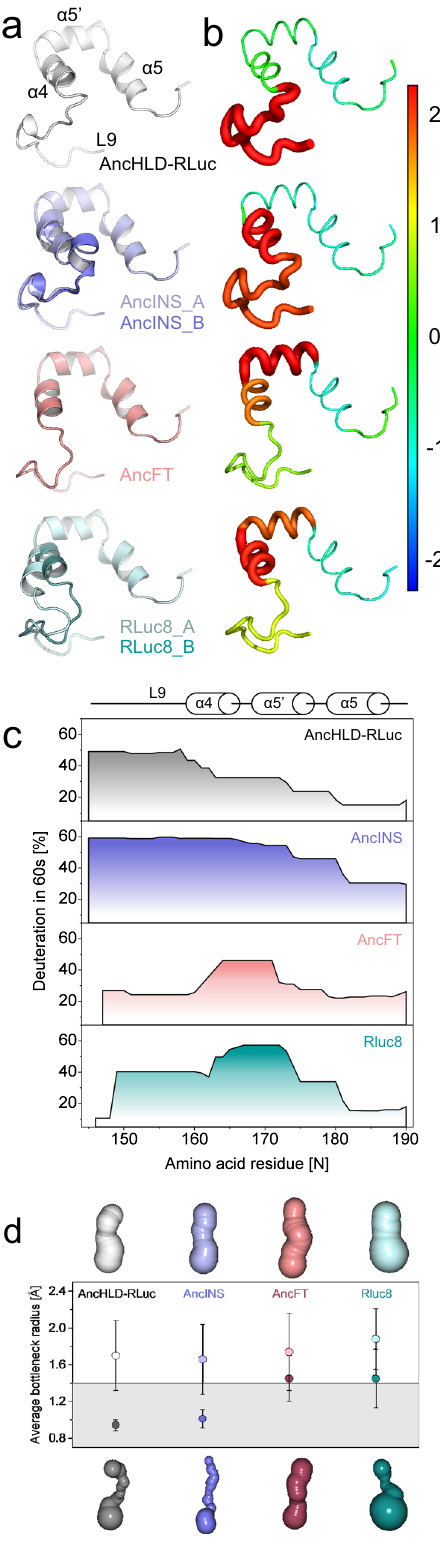
Fig. 6 Engineering conformational dynamics by backbone modi fi cations. a Conformational dynamics in the cap domains of crystal structures: AncINS (PDB ID 6S6E) has two monomers in the asymmetric unit differing in conformation of the α 4 helix carrying the insertion. Chains A (light blue) and B (slate) are in the open and closed conformations, respectively. RLuc8 (PDB ID 2PSF) has analogous conformations, with an open chain A (pale cyan) and a closed chain B (light teal). AncFT (PDB ID 6S97) has one monomer in the asymmetric unit, in which helix α 4 is more open than in Anc HLD-RLuc , AncINS, and even RLuc8 chain B. b Conformational dynamics in the cap domains observed during molecular dynamics simulations. B- factors of backbone atoms standardized across all protein variants, ranging from − 2 (blue) to 2 (red). B-factor values standardized for each protein are indicated by the thickness of the lines representing the protein backbone. Values were averaged per secondary structure element. c Dynamics and hydration of the cap domain based on HDX-MS assessments of peptide deuteration after 60 s. Anc HLD-RLuc is most heavily deuterated in the L9 loop. The deuteration pattern of AncFT is most similar to that of RLuc8. d Main access tunnel geometries of the proteins: representative snapshots of the open (lighter shades, upper row) and closed (darker shades, lower row) conformations. Average bottleneck radii and standard deviations from n = 1000 snapshots from MD simulations were calculated by Caver 3.02 23 . The grey area corresponds to closed conformational states with tunnel radii below 1.4 Å (the radius of a water molecule). Source data is available as a Source data fi le for Fig. 6b and